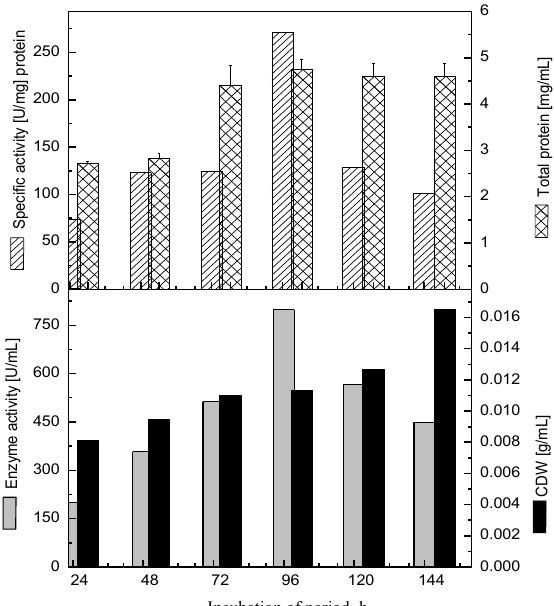
Figure 3. Effect of incubation period on proteases production by Str. pseudogrisiolus NRC- 15 on 200 rpm at 96